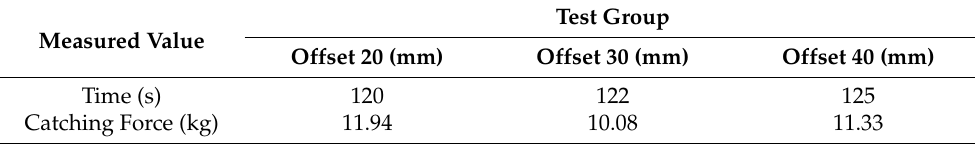
Table 3. Four groups of contact force and buffering force.